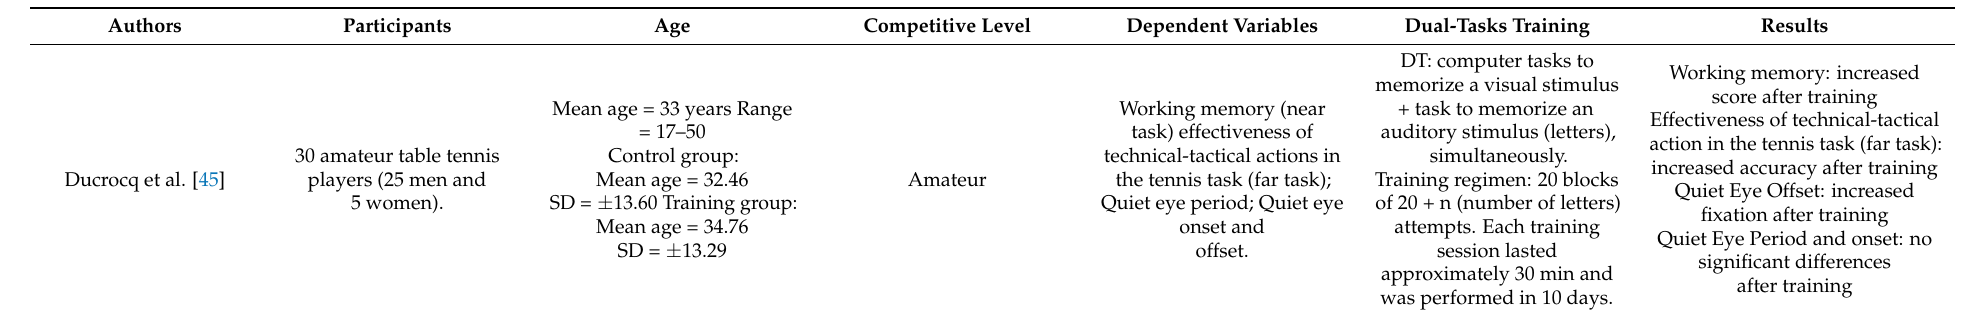
Table 3. Selected studies on the chronic effect of